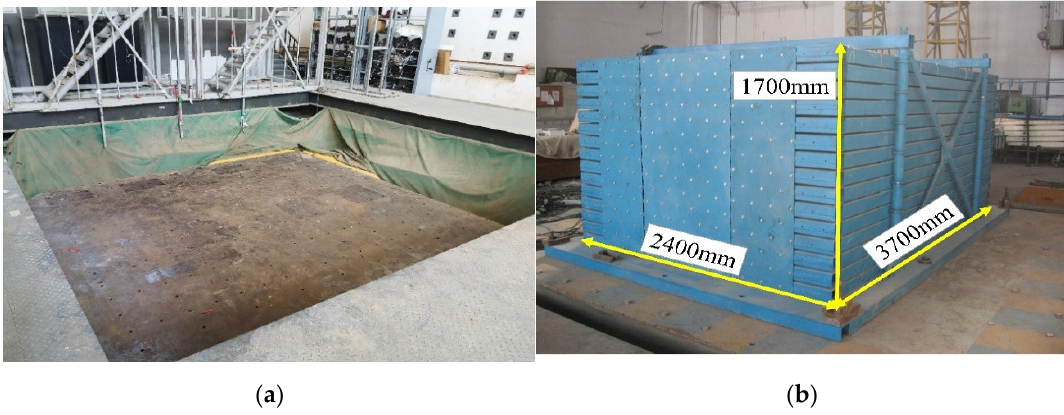
Figure 2. Test equipment: ( a ) shaking table system; ( b ) laminated shear box. Table 1. Similarity ratios of the structural model.